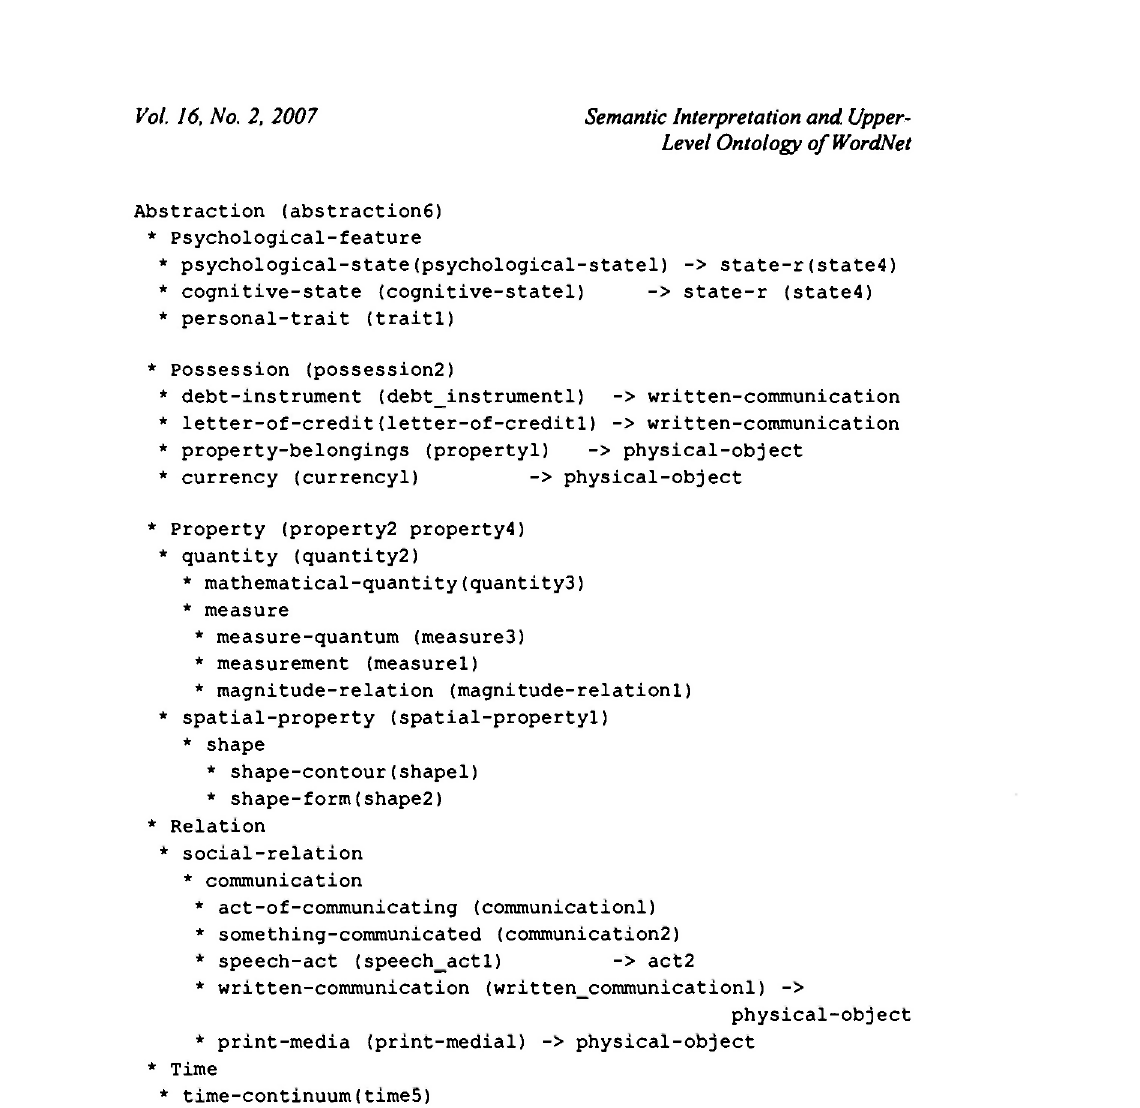
Hierarchy for main upper-level concepts of